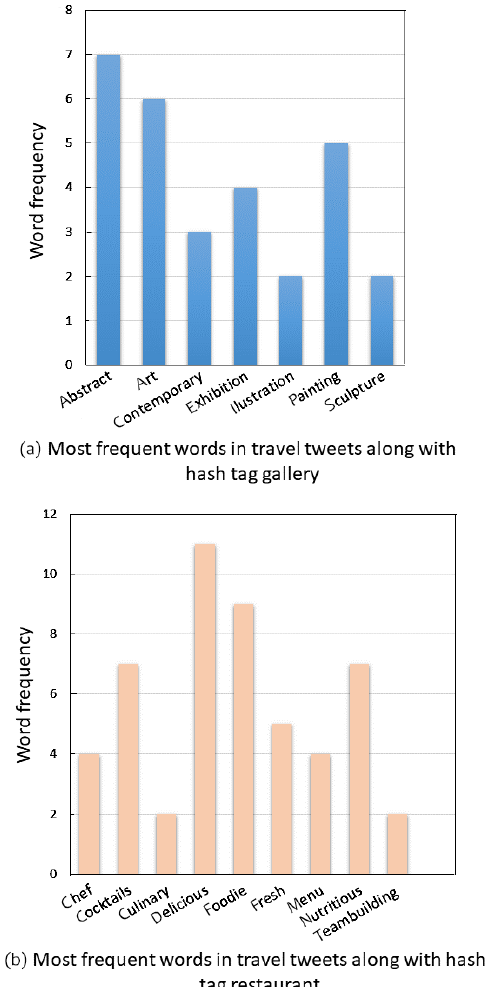
Fig. 2 Mining relevant words by place of interest category.